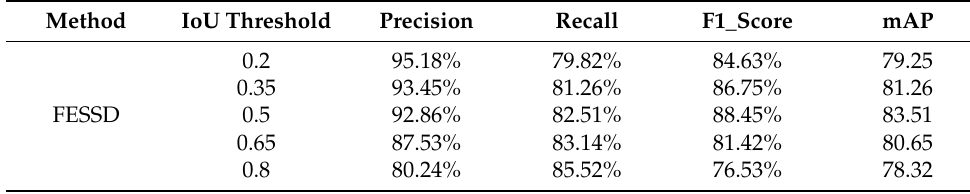
Table 2. The impact of different IoU thresholds on model performance.